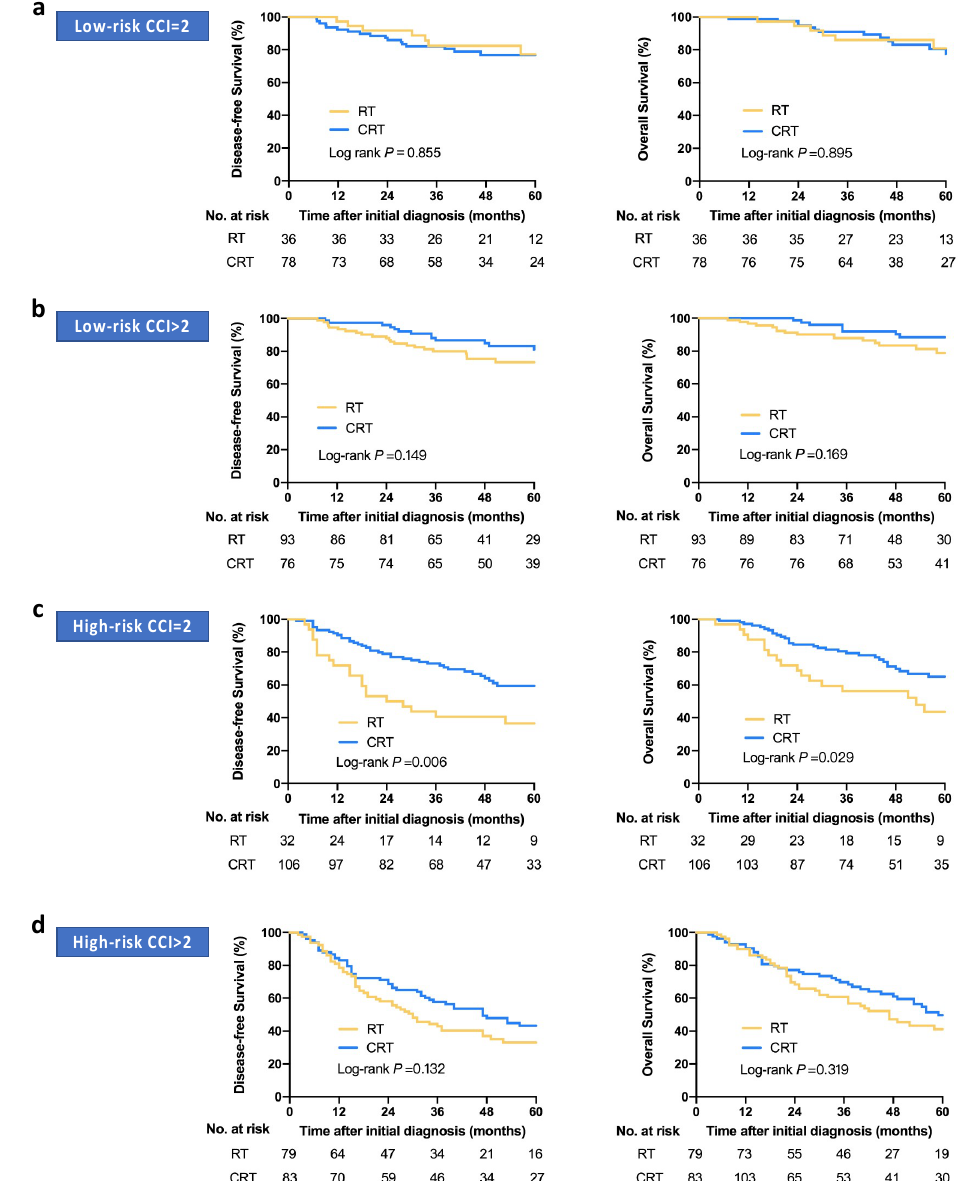
Figure 4. Kaplan–Meier DFS and OS curves of different treatment regimens in subgroups analysis. Survival outcomes of different treatment regimens in the low-risk groups with CCI = 2 ( a ), in the low-risk groups with CCI >2 ( b ), in the high-risk groups with CCI = 2 ( c ) and in the high-risk groups with CCI >2 ( d ); RT, radiotherapy; CRT, radiotherapy combined with chemotherapy; DFS, disease-free survival; OS, overall survival.